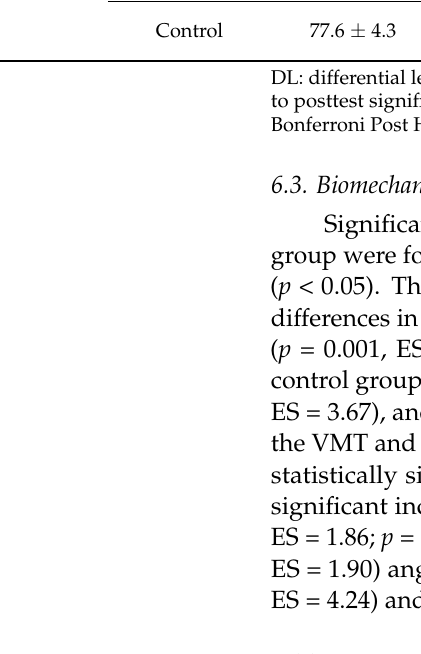
Table 7. Statistical results for between and within-group changes of kinetic and